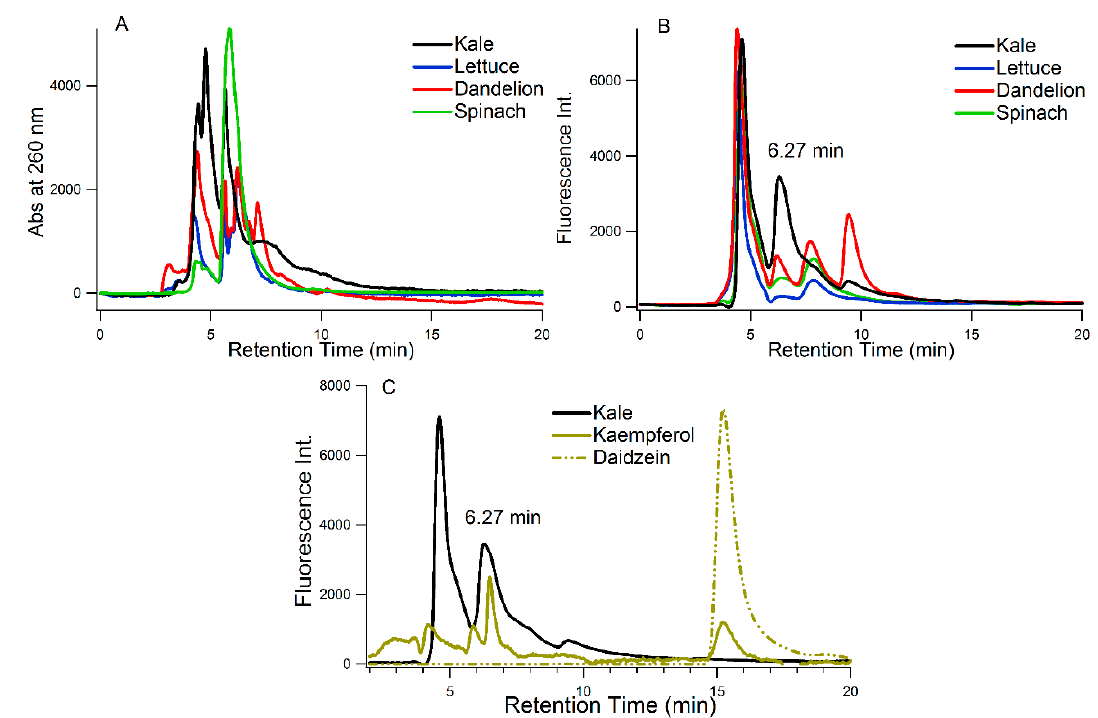
Figure 9. Typical chromatograms of the HPLC analysis of the juices of dandelion, lettuce, spinach, and kale using 50% methanol/H 2 O mobile phase on a C18 column with flow rate 0.5 mL/min. Panel ( A ) shows absorption ( λ abs = 260 nm) and panels ( B ) and ( C ) show fluorescence ( λ ex / λ em = 350/450 nm) measurements made using Jasco inline MD-4010-PDA and FP-4025 fluorescence detectors, respectively, where the time delay between the detectors was in the range of ~0.1 s.